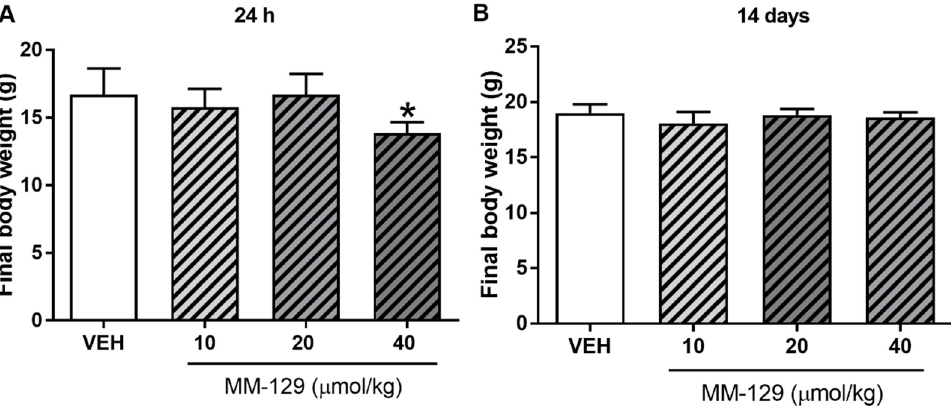
Figure 7. Final body weight of mice exposed to MM-129 concentrations or vehicle (VEH) after short-term administration ( A ) and long-term administration ( B ). Data are shown as mean ± SD; * p < 0.05 vs. VEH within the group n = 6–10 for each concentration. Abbreviations: MM-129—pyrazolo[4,3-e]tetrazolo[4,5-b][1,2,4]triazine sulfonamide; VEH—vehicle